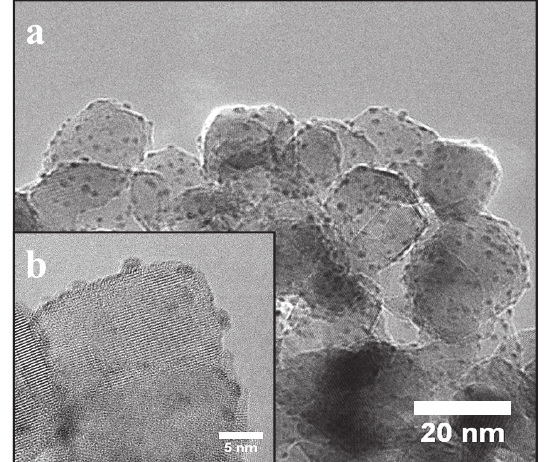
Fig. 7 TEM image of the Pt nanoparticles decorating the surface of the TiO 2 support after 1 ALD cycle of 3 min Pt precursor exposure. The inline image depicts the decoration at the edge of the TiO 2 crystal.